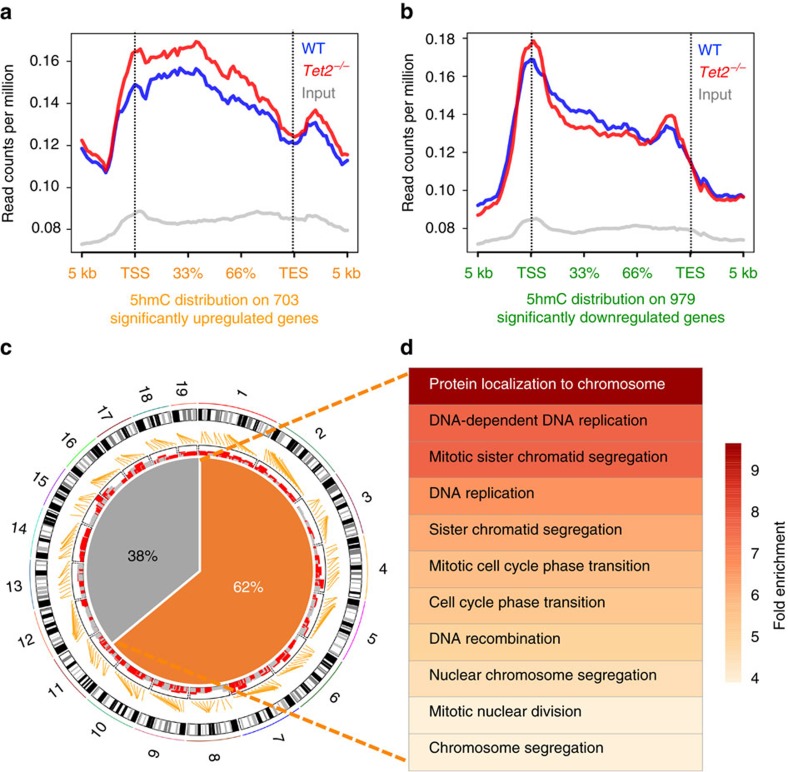
Intragenic 5hmC dynamics largely correlated with transcriptome alterations in aNSCs.(a,b) Significantly upregulated (a, n=703) and downregulated genes (b, n=979) in aNSCs in the absence of Tet2 were normalized to 1–100% as relative positions. 5 kb upstream of transcription start sites (TSS) and downstream of transcription end sites (TES) were included. Average normalized 5hmC mapped reads per million from WT, Tet2−/−, and non-enriched input DNA were calculated in each bin of each gene, and average bin values from all genes were plotted. 5hmC in Tet2−/− showed higher enrichment on the gene bodies of upregulated genes and lower enrichment on downregulated genes compared to 5hmC from WT aNSCs. The entire transcripts from transcription start sites (TSS) to transcription ending sites (TES) were referred as intragenic regions. (c) Circular map view of upregulated genes in the absence of Tet2 and their correlation with 5hmC are indicated. Each mouse chromosome is shown in the black-and-white outer track. Orange lines attached to the chromosomes indicate the chromosomal locations of 703 upregulated genes. Intragenic 5hmC reads ratio between WT and Tet2−/− aNSCs were calculated on these genes and indicated in the inner track, with red bars demonstrating higher intragenic 5hmC in Tet2−/− aNSCs and grey bars showing lower intragenic 5hmC in Tet2−/− aNSCs. Pie chart summarizes these results and indicates 62% of upregulated genes (n=439; binomial test, P<0.0001,) carried higher intragenic 5hmC in Tet2−/− aNSCs than WT. (d) GO analyses on 439 upregulated genes bearing higher intragenic 5hmC in Tet2−/− preserved GO terms related to the cell cycle and proliferation. Fold enrichment is demonstrated by heatmap view.